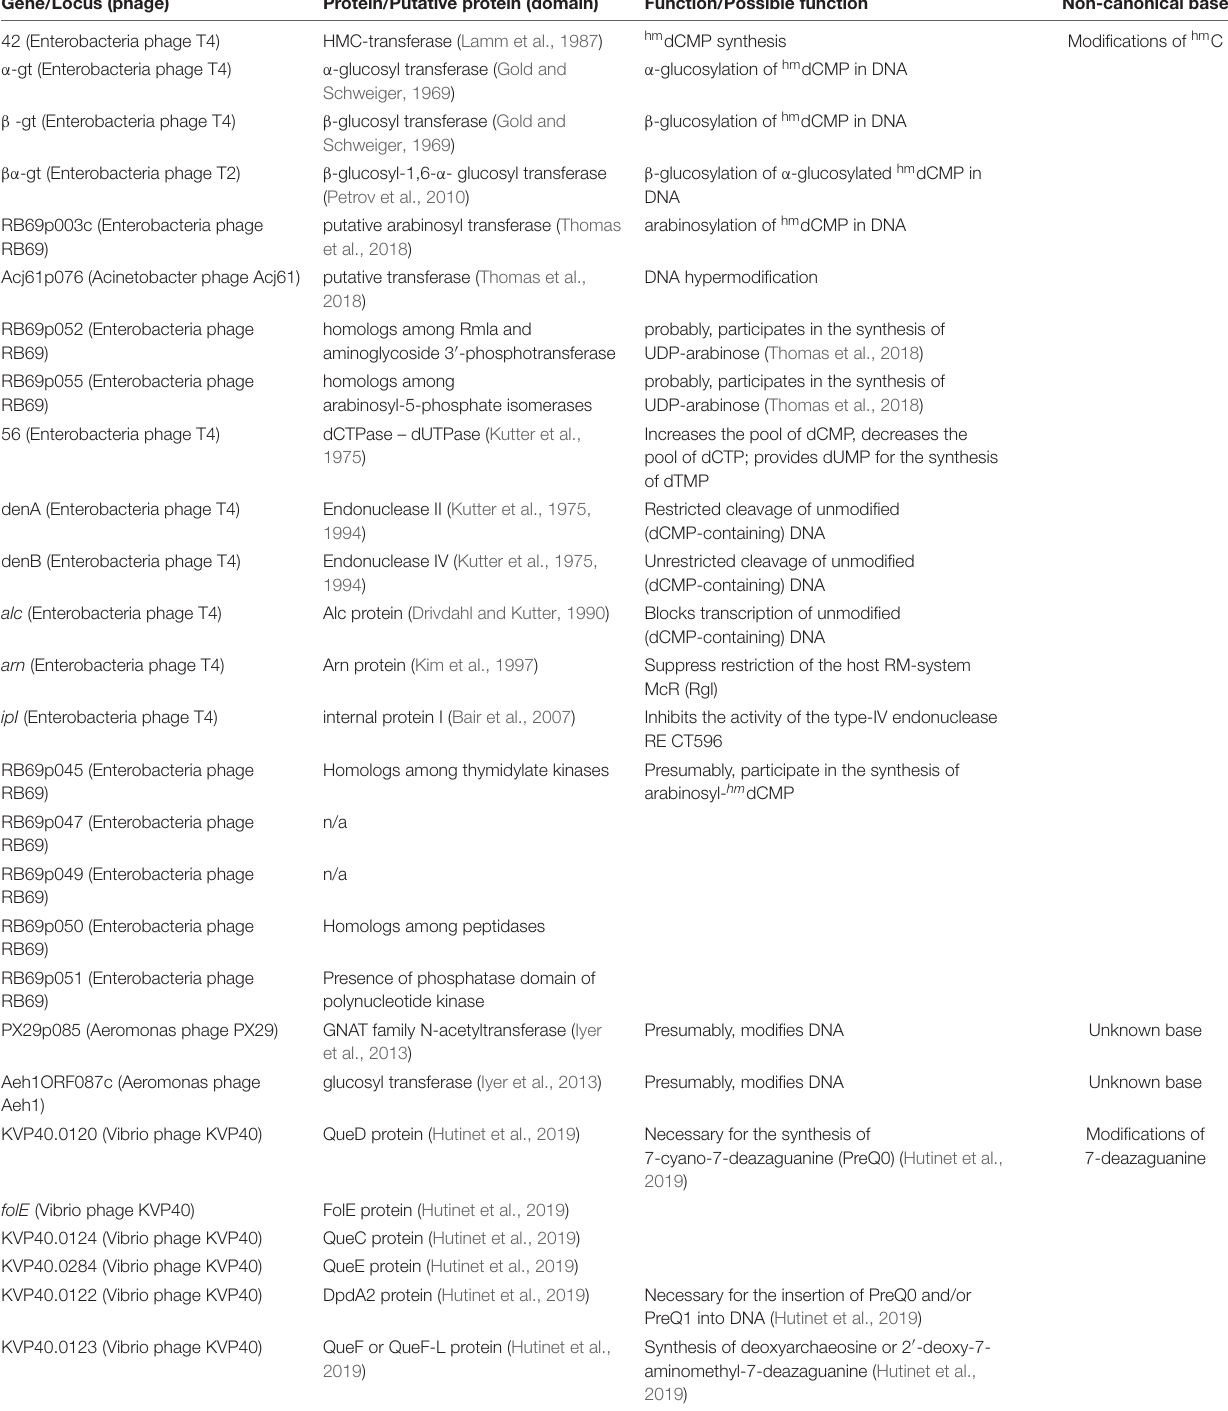
TABLE 2 | Proteins associated or hypothetically associated with non-canonical